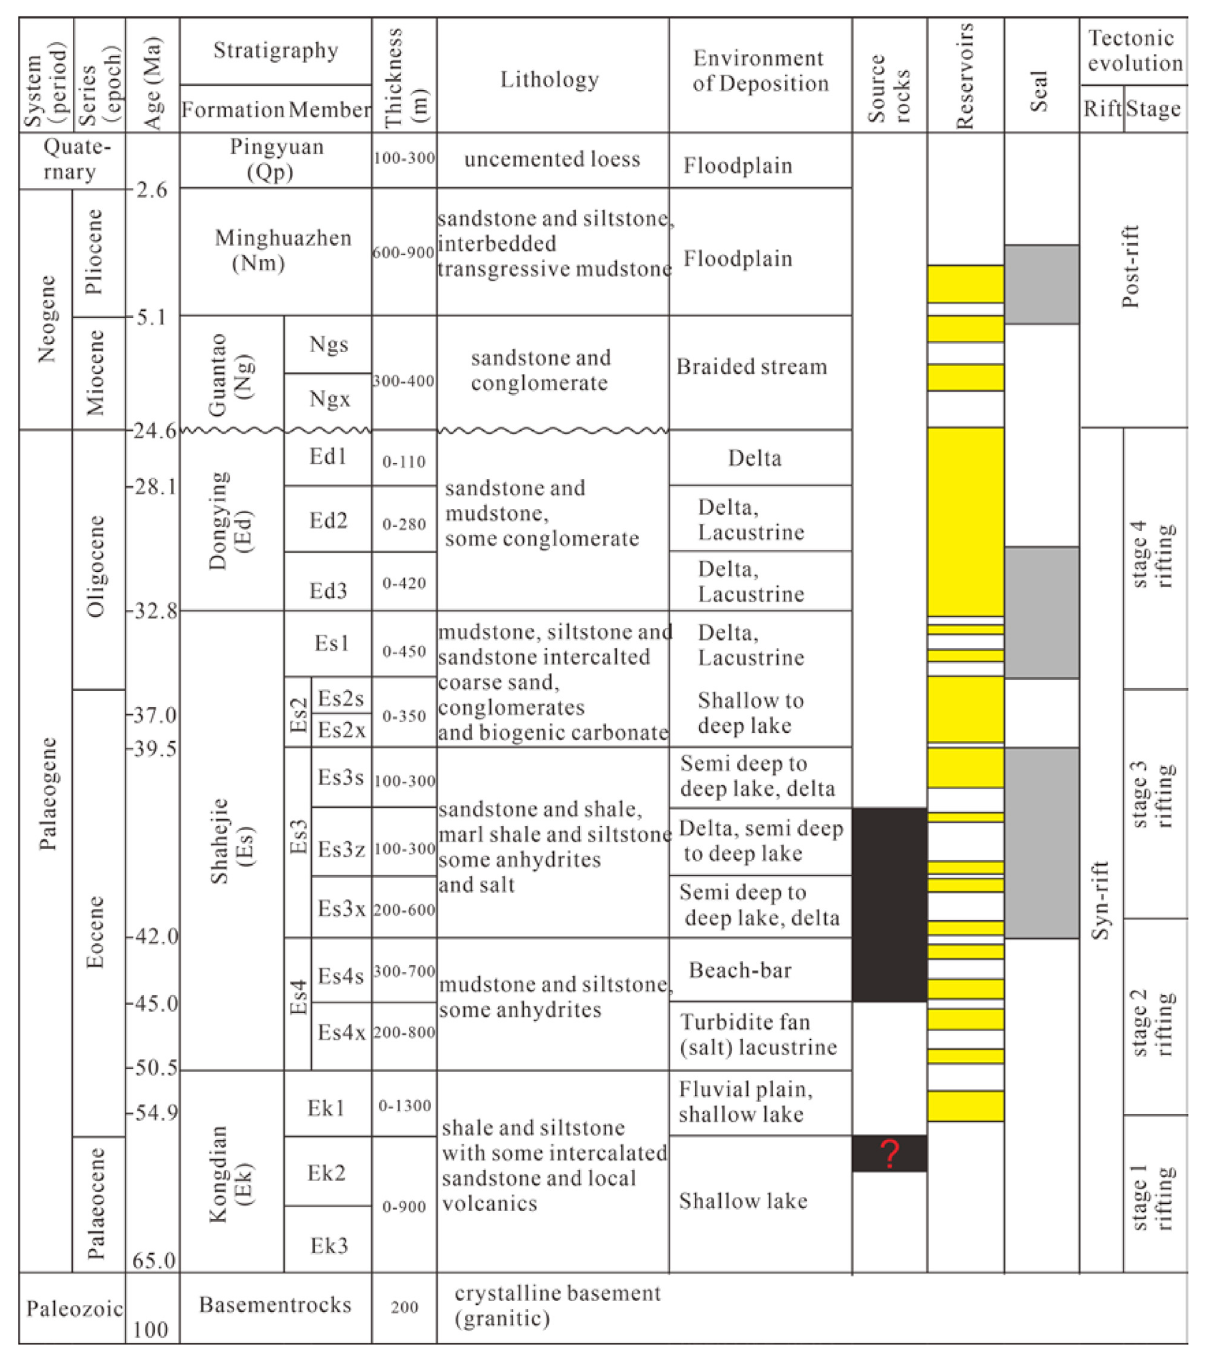
FIGURE 2 GeneralizedPalaeogene-QuaternarytectonicandsedimentaryevolutionstagesandmajorpetroleumsystemelementsintheDongyingSag(revised from Zahid et al.,